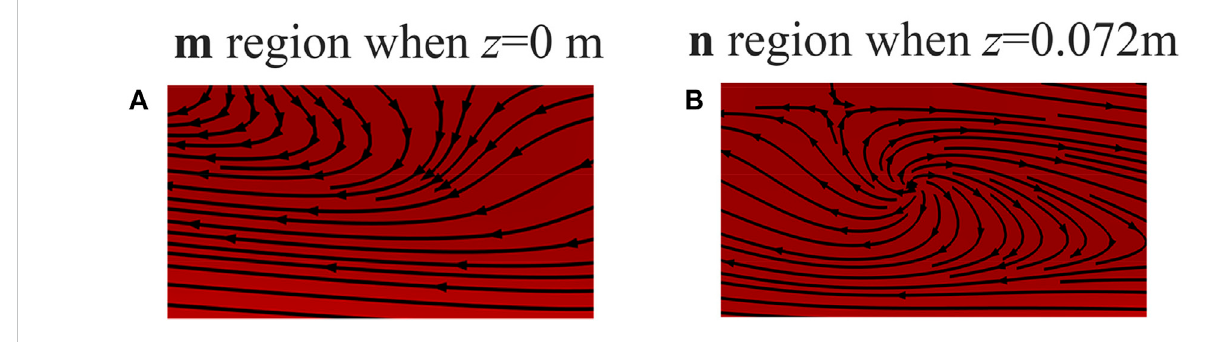
FIGURE 6 Streamlines of the protection velocity fi eld in: (A) m region, and (B) n region.